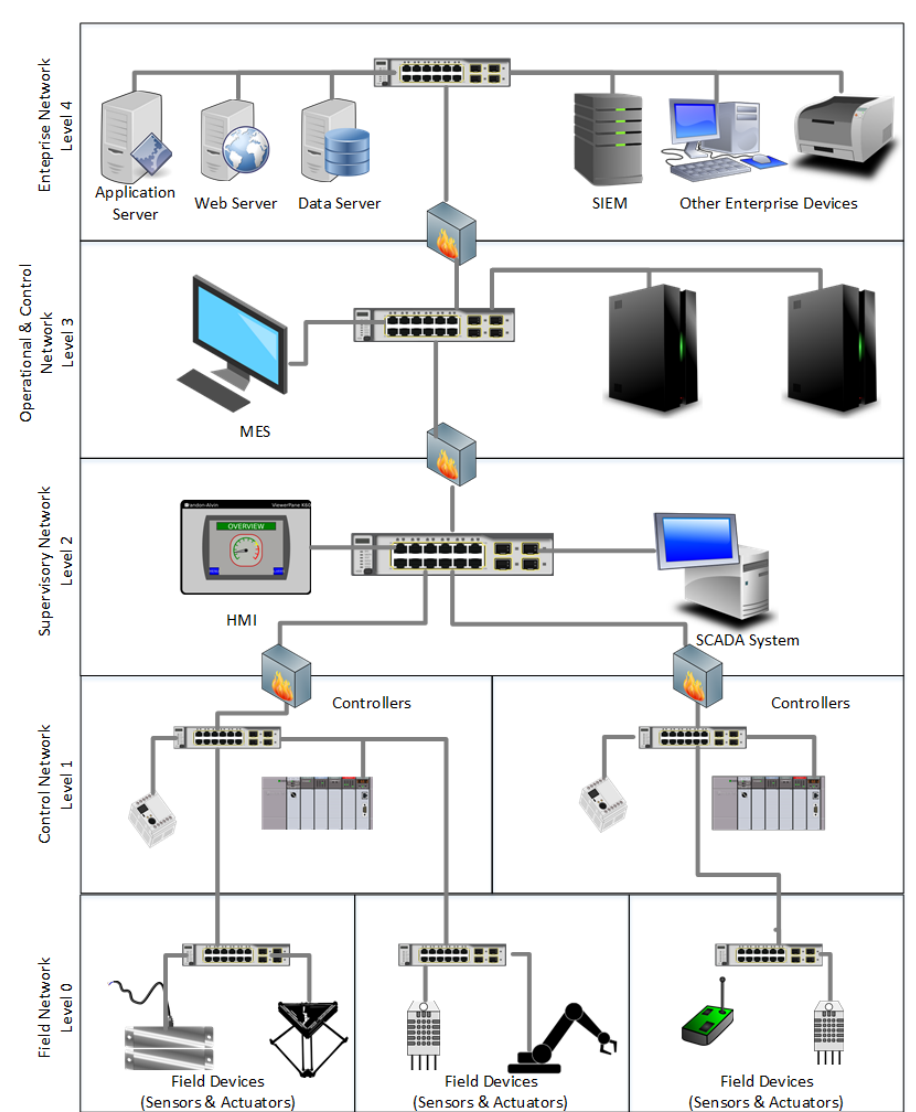
Figure 1. Reference Industrial Automation System Architecture derived from [15–17]. SIEM: Security Incident and Event Management; MES: Manufacturing Execution System; SCADA: Supervisory Control and Data Acquisition; HMI: Human Machine